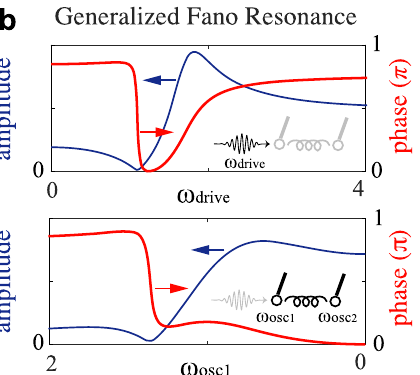
Fig. 1 | Nonlinear terahertz spectroscopy of d -wave superconductors. a An illustration of the amplitude oscillation of the superconducting order parameter (2 ω ) driven by electromagneticradiation ( ω ) and itscoupling to anothercollective mode (black pendulum) at temperatures above and below T π , i.e., the anti- resonance temperature. b The generalized Fano resonance model describes the interference between a driven damped (continuum) mode and an underdamped (discrete) mode, here represented as oscillators 1 and 2, respectively. The Fano resonance/interference is characterized by the asymmetrical line shape of the amplitude response (blue), and also by the negative π jump in the phase response (red), a.k.a. the anti-resonance. Upper panel: in typical spectroscopy experiments, the electromagnetic driving frequency ( ω drive ) is swept. Lower panel: in our